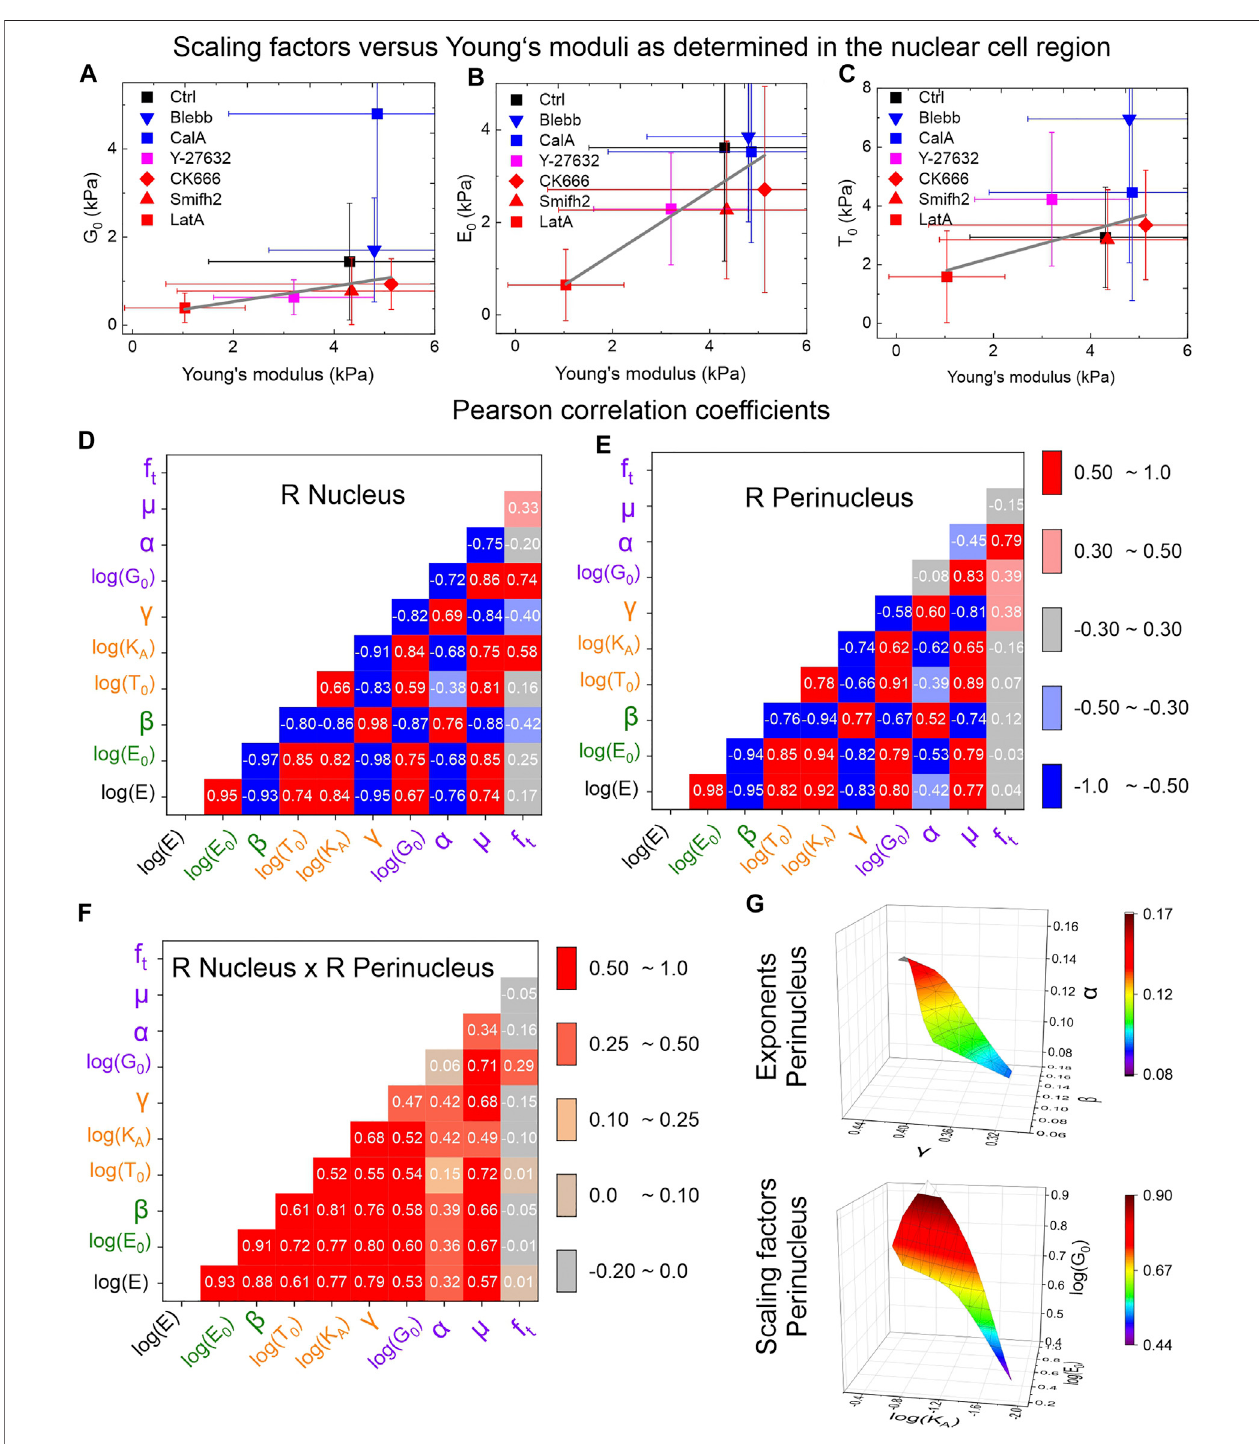
FIGURE 5 | Correlations among all of parameters extracted from the different rheological tests. (A – C) Correlation of the Young ’ s modulus to G 0 , E 0 and T 0 , as determined within the nuclear region of hTERT RPE1-cells; error bars represent standard deviations. Cell numbers N are in the following order: Ctrl, Blebb, CalA, Y-27632,CK-666,Smifh2, LatA: (A) N (cid:1) 81, 114,58, 80,92,69, 66; (B) N (cid:1) 106, 172,76, 102,126,90,80; (C) N (cid:1) 75,108, 64,75,78, 66,57. (D,E) Correlations among all of the accessible parameters of all of the three rheological tests, as well as the Young ’ s modulus as determined within the nuclear and perinuclear region. (F) Multiplication of Pearson R coef fi cients of each respective pair belonging to nucleus and perinucleus. (G) Three dimensional correlations between the scaling factors ( “ stiffnesses ” ) and exponents ( “ fl uidity ” ) of creep compliance ( E 0 , β ), stress relaxation ( K A , c ) and microrheology ( G 0 , α ); representation of the z-axis corresponds to the color code. Cell numbers N for correlations are based on seven data points each (see A – C ). Therefore indirectly, each Pearson correlation coef fi cient between tests in (D) and (E) is based on typically N (cid:1) 500 – 750 single cells (addition of cell numbers for the seven (drug) conditions for two tests).